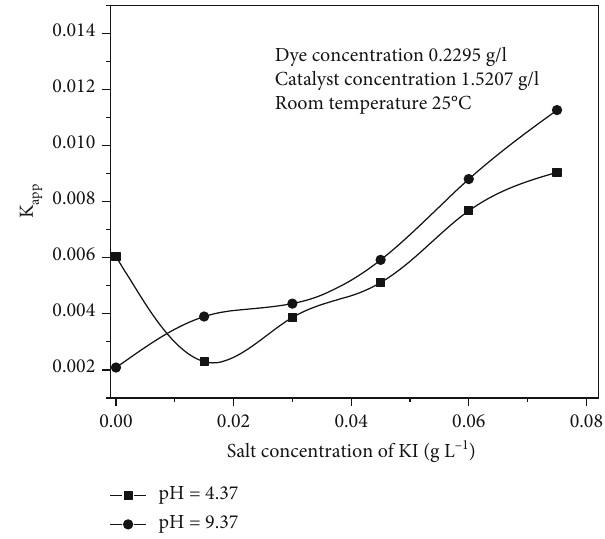
Figure 5: E ff ect of KI on the apparent rate constant of photocatalytic